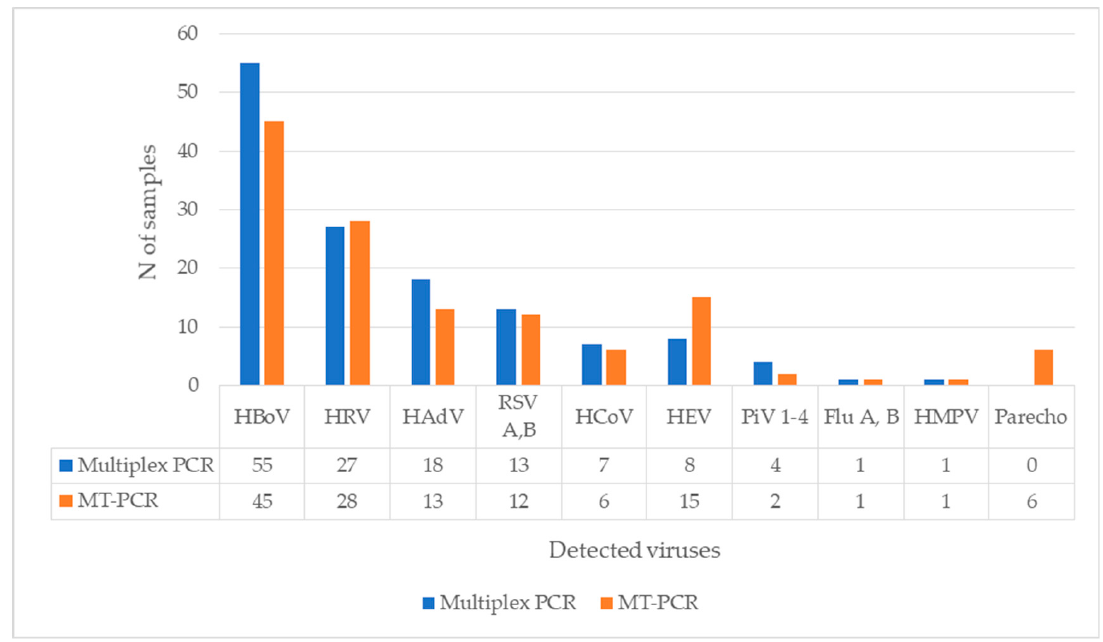
Figure 2. Codetection of HBoV with other respiratory viruses, a comparison of multiplex PCR and MT-PCR ( N of samples =